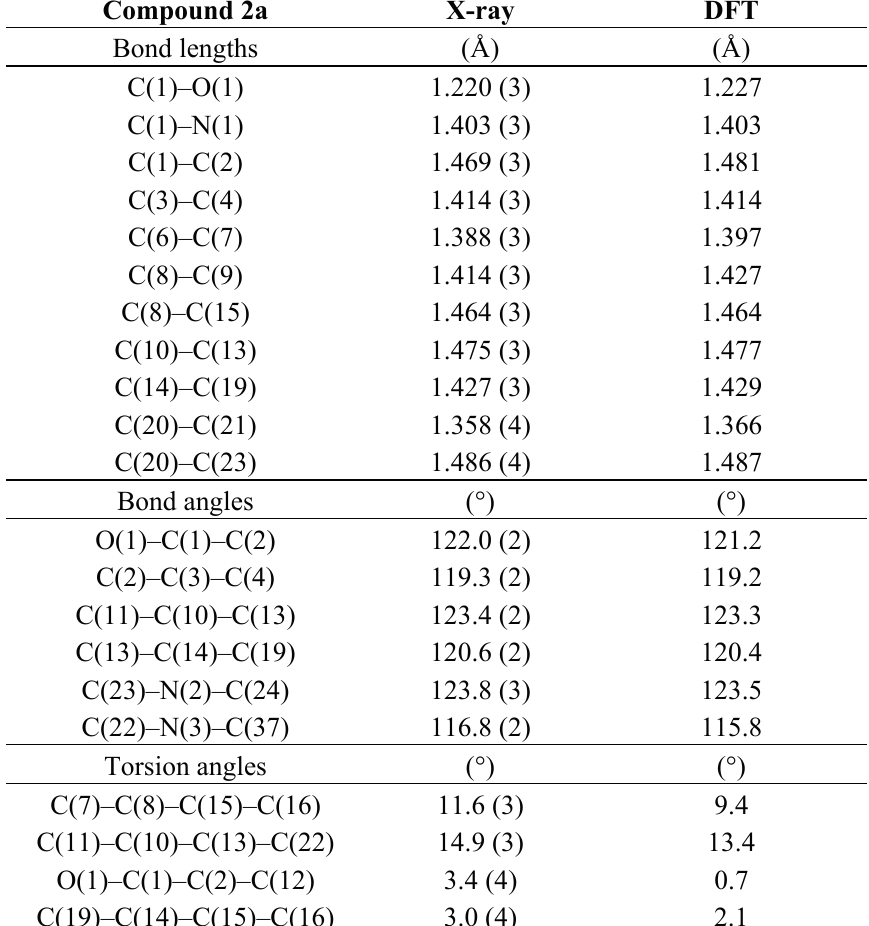
Table 1. Comparison of the experimental and optimized geometric parameters of 2a (Å and